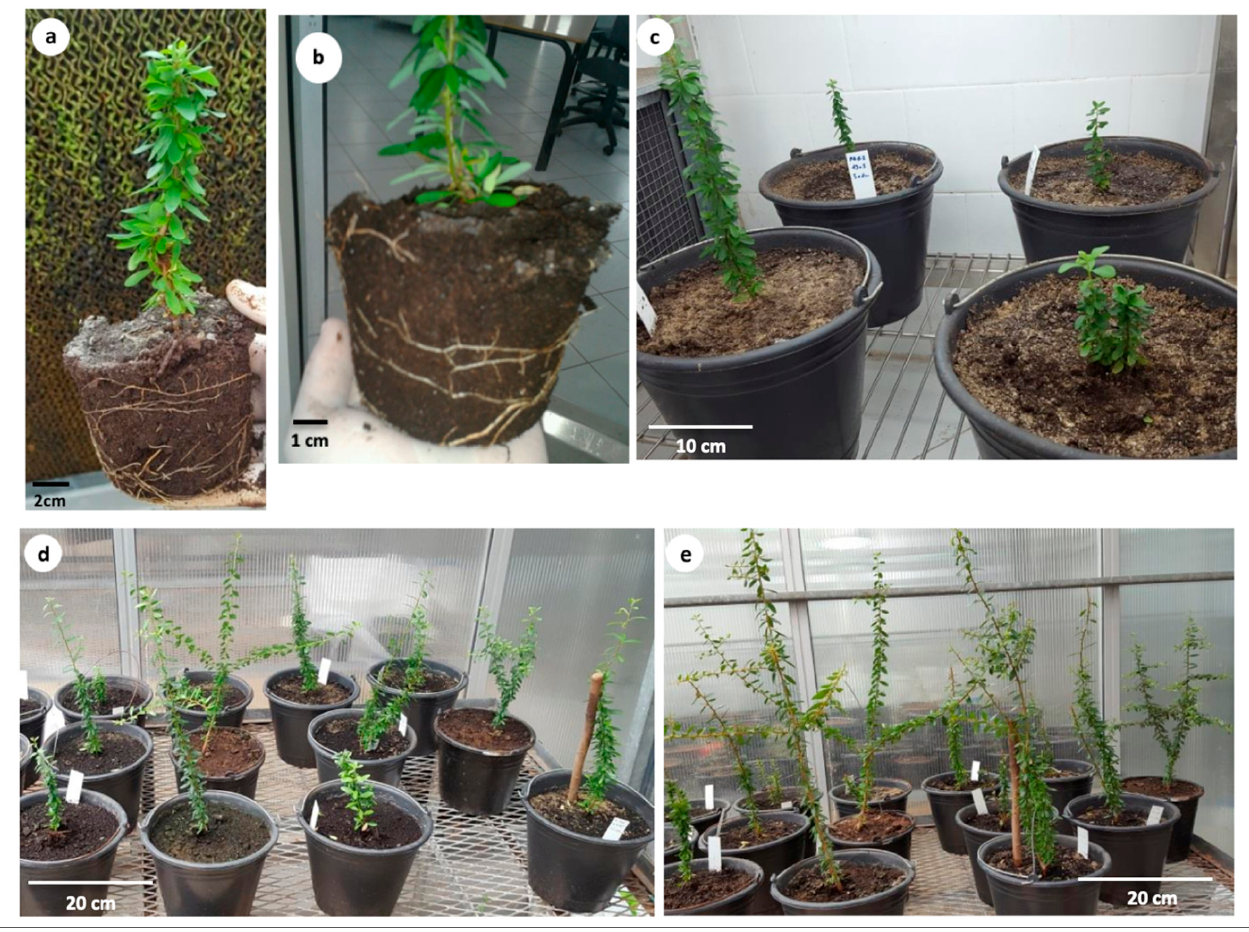
Figure 3. Acclimatization of argan plantlets. ( a – c ) plantlets of genotypes “Mejji” ( a ) and “R’zwa” ( b , c ) after 4 weeks in the glasshouse. ( d ) Plantlet growth after 10 weeks in the glasshouse. ( e ) Plantlet growth after 16 weeks in the glasshouse.